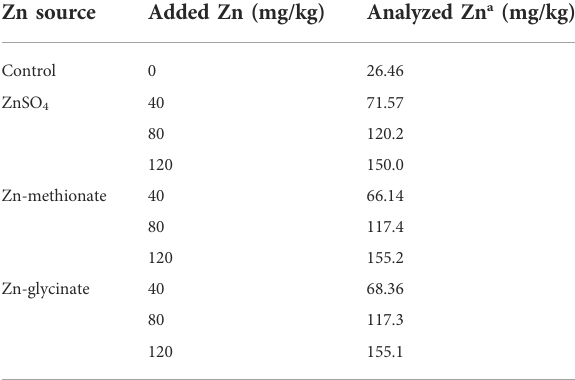
TABLE 2 Analyzed Zn concentrations in different diets for starter broilers (as-fed basis). Zn